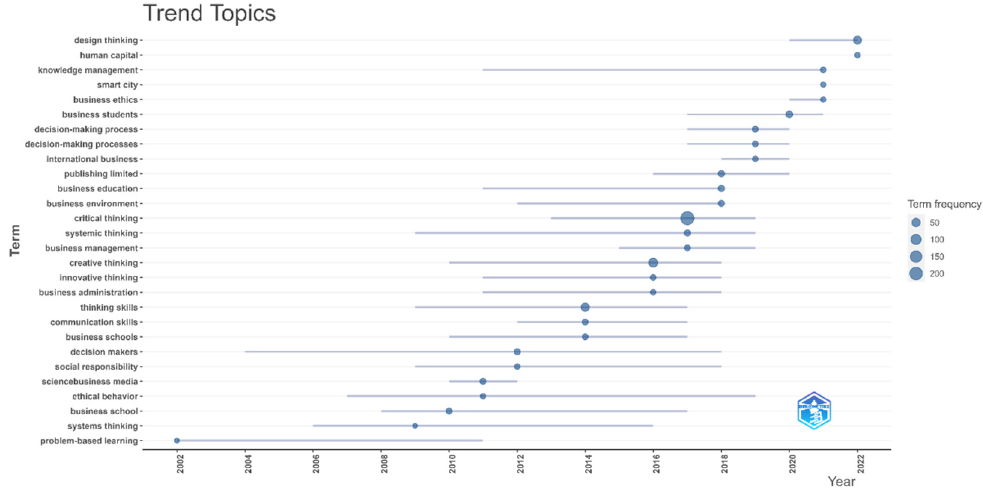
Figure 8. Trending topics per year. Source: Created by the authors through Bibliometrix.